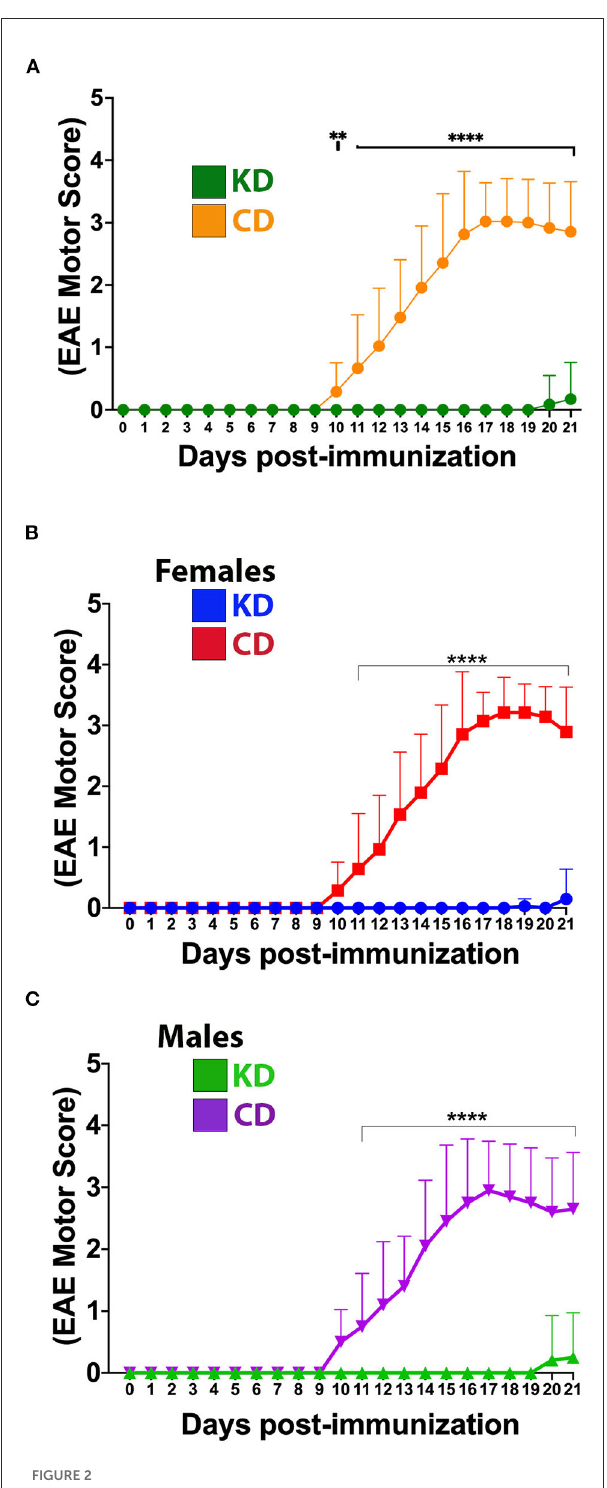
FIGURE2 The KD prevents EAE-induced motor deficits. (A) Daily motor scores of EAE mice on the KD (green) vs. the CD (orange). (B) Daily motor scores as a function of diet for female mice. Blue trace shows data for KD-fed mice and red trace shows data for CD-fed mice. (C) Daily motor scores as a function of diet for male mice. Green trace shows data for KD-fed mice and purple trace shows data for CD-fed mice. N = 10–17 mice/sex/diet. Whisker-bar standard deviations and p -values for differences between curves were computed with mixed linear model implementation of lme function, nlme R package. Asterisks denote statistical significance: ** p < 0.01, **** p < 0.0001. All data compiled ≥ 4 independent